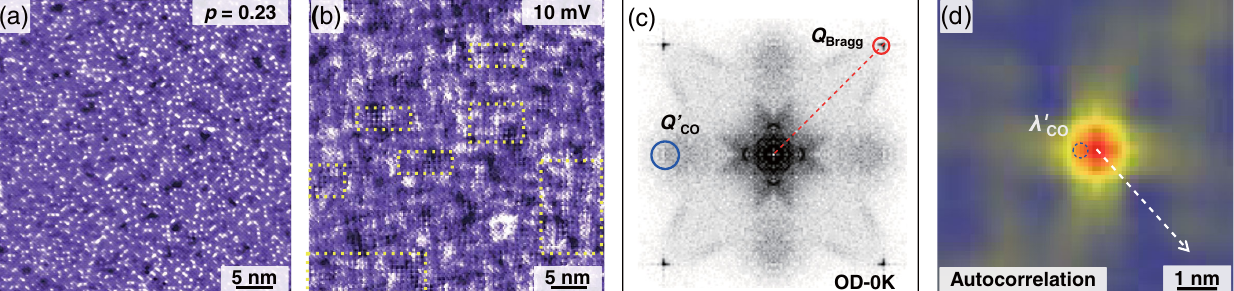
FIG. 4. The overdoped OD-0K sample with p ¼ 0 . 23 . (a) Atomically resolved topographic image acquired at V ¼ 100 mV and I ¼ 5 pA over an area of 350 × 350 Å 2 . (b) The dI=dV map measured in the same area as (a) at bias voltage V ¼ 10 mV. The patches ffiffiffi p ffiffiffi p 2 2 of short-range × order are indicated by the broken yellow squares. (c) The Fourier transform map of (b) displaying the Bragg peaks in the red circles, as well as the short-range central cross and the spot in the circle indicate the short-range